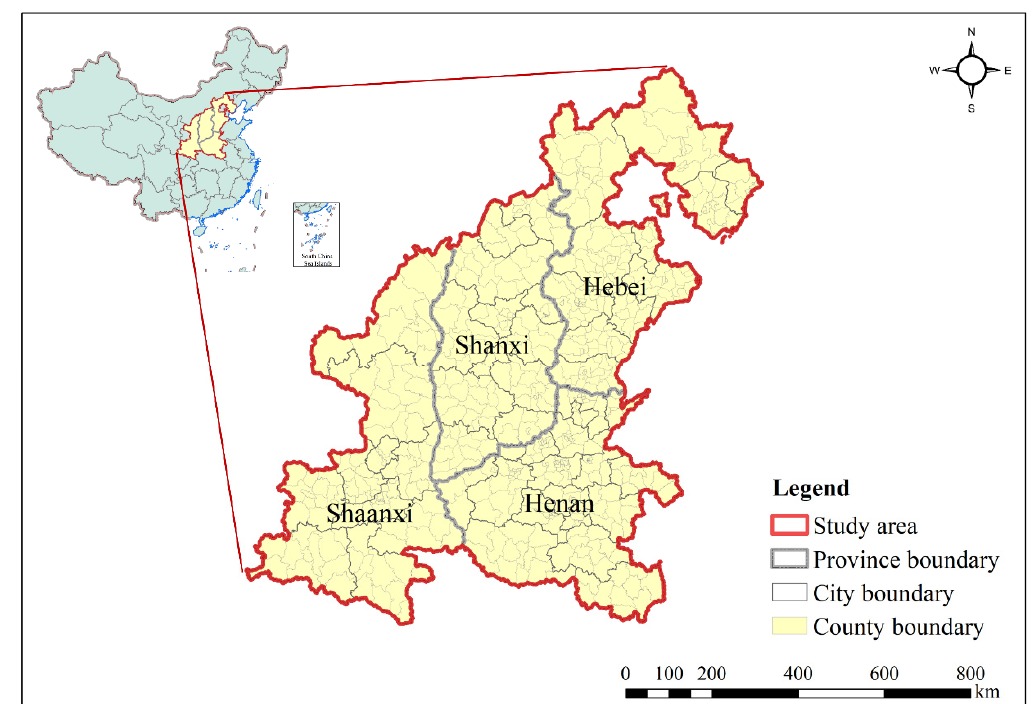
Figure 1. The study area adopted in this study. Central China included provinces of Shaanxi (city: 11, county/district: 108, population: 38.76 million, area: 0.20 million km 2 ), Shanxi (city: 11, county/district: 119, population: 37.29 million, area: 0.16 million km 2 ), Henan (city: 18, county/district: 169, population: 96.4 million, area: 0.17 million km 2 ), and Hebei (city: 11, county/district: 176, population: 75.92 million, area: 0.19 million km 2 ).